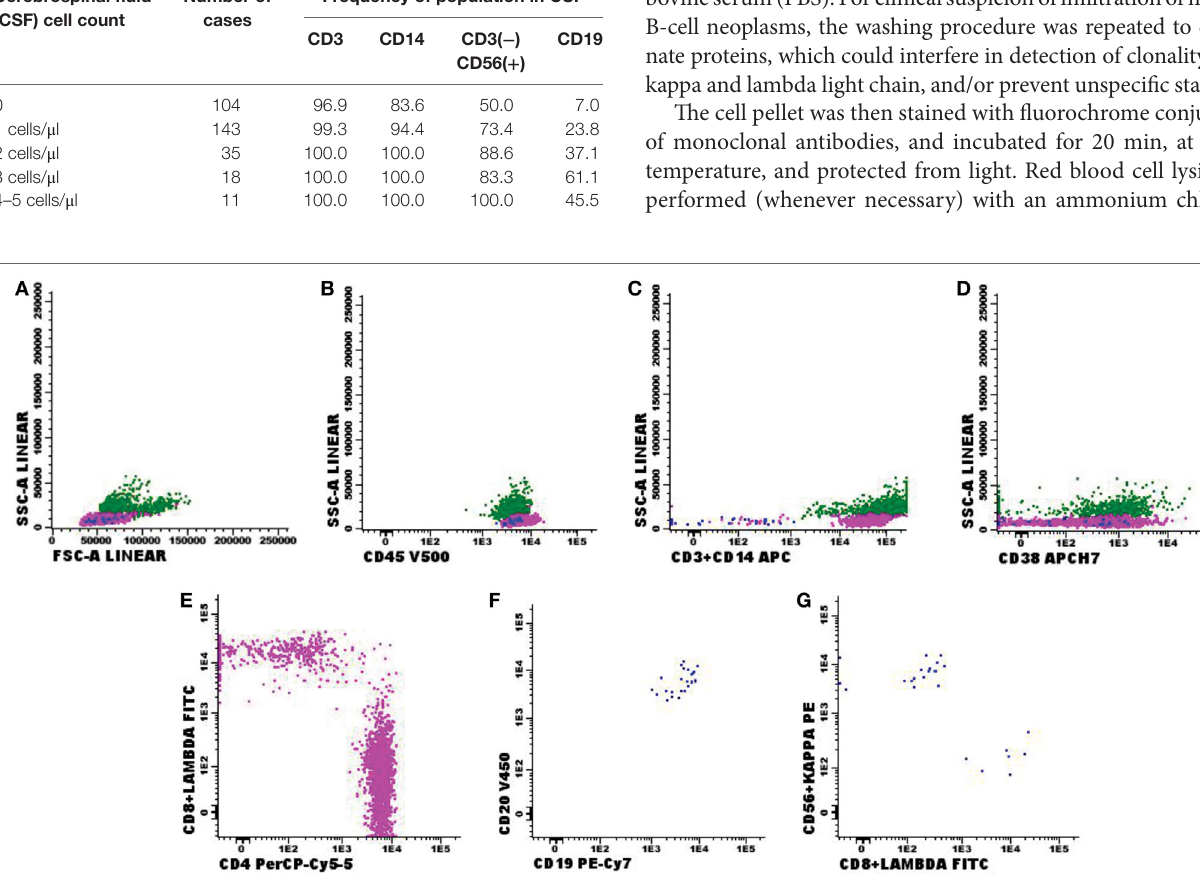
Table 2 . All antibodies were standardized, titrated, and validated by our